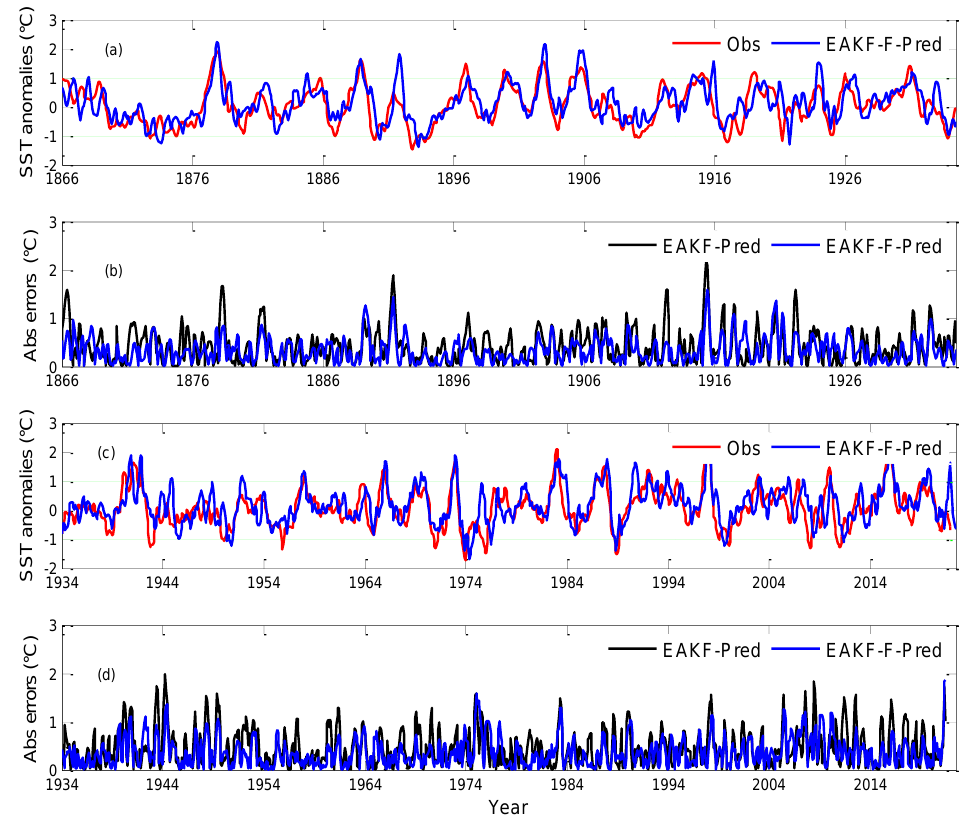
Figure 10. Time series of ( a , c ) observed and forecasted Niño3.4 SST anomalies using EAKF_F-Pred with a lead time of 6 months, and ( b , d ) AEs of forecasted Niño3.4 SST anomalies using EAKF-Pred and EAKF_F-Assim schemes with a lead time of 6 months.